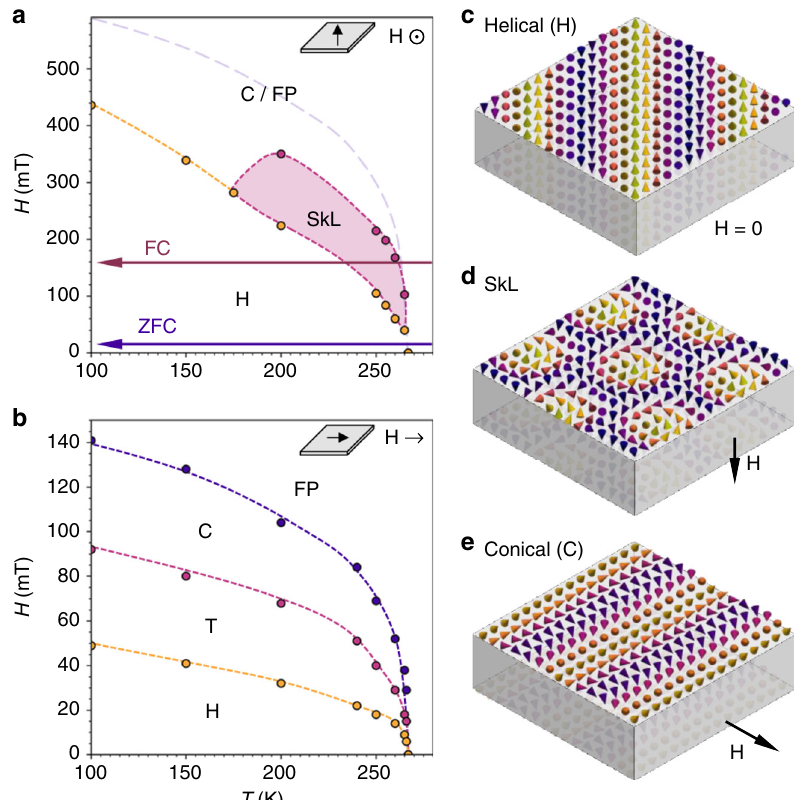
Fig. 2 Spin textures and magnetic phase diagrams of an FeGe lamella. a , b Phase diagrams of the ~120 nm FeGe lamella for out-of-plane and in-plane applied magnetic fi eld, respectively, as determined magnetic x-ray diffraction. Schematics of each fi eld con fi guration are shown as insets. In a , boundaries between the helical (H) and skyrmion lattice (SkL) states are displayed by yellow and magenta dots. The expected boundary between the indistinguishable conical (C) and fi eld polarised (FP) states is estimated by the purple dashed line. The zero- fi eld cooling (ZFC) and fi eld cooling (FC) procedures are indicated. In b , yellow, magenta and purple dots boundaries indicate the boundaries between the helical (H), helical rotation transition (T), conical (C) and fi eld polarised (FP) states. c – e Schematic illustrations of the spin textures as they are expected to appear in a thin